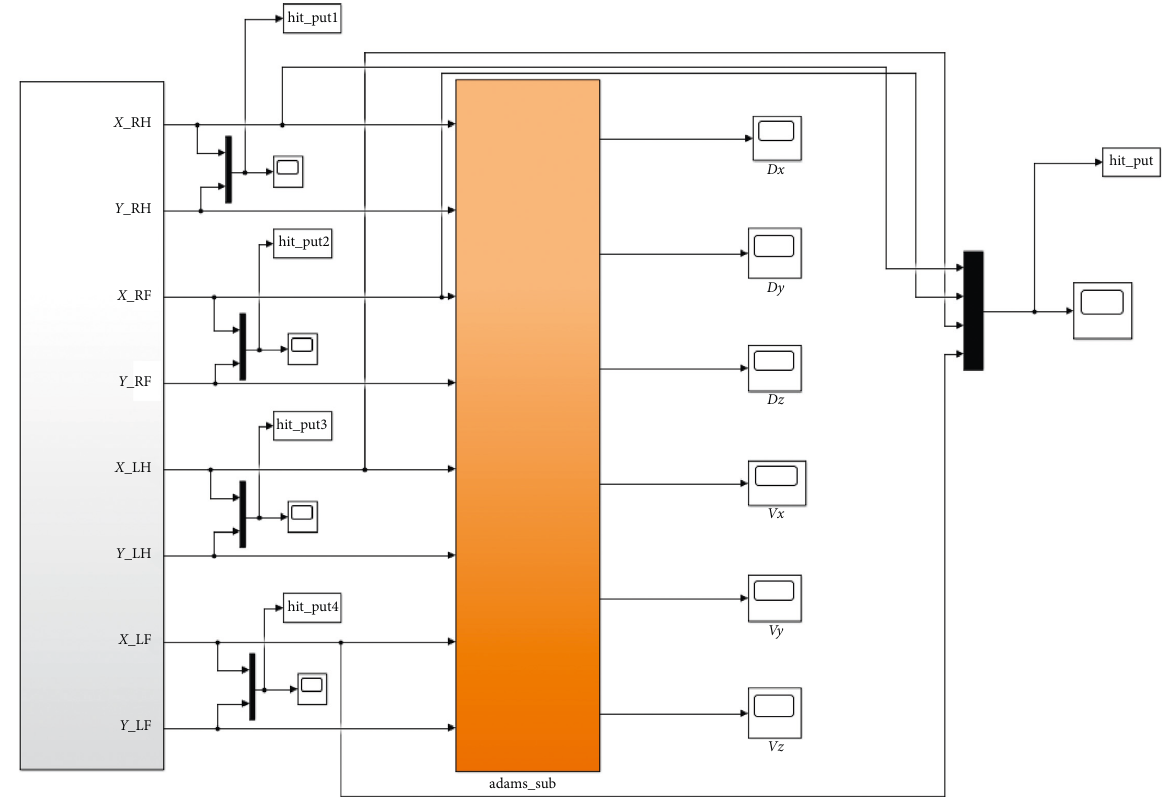
Figure 6: ADAMS & Simulink cosimulation platform.